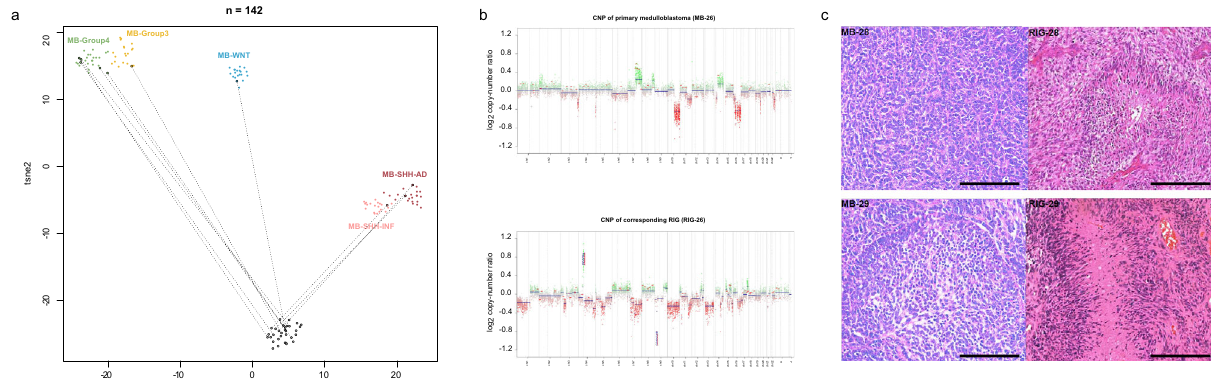
Fig. 4 Comparison of matched primary MB and post-radiation glioma samples. T-SNE analysis of primary MB and post-MB RIG compared with existing MB subgroups ( a ) and representative copy-number pro fi le ( b ) reveal distinct genome-wide methylation patterns and recurrent high-level PDGFRA ampli fi cation and CDKN2A/B deletion. Available primary MB and post-MB RIG samples ( n = 11 pairs) were investigated with 100 MB reference samples representing established MB subtypes 57,70 . MB and RIG pairs from our series were encircled and linked with dotted lines. Histological staining for hematoxylin and eosin ( c ) of two paired primary medulloblastoma and radiation-induced gliomas (MB/RIG_28, MB/RIG_29) display distinct morphological characteristics. Scale bar represents 200 μ m. T-SNE t-stochastic neighboring embedding, MB medulloblastoma, MB-SHH-INF medulloblastoma sonic- hedgehog infant subgroup, MB-SHH-AD medulloblastoma sonic-hedgehog adult subgroup, CNP copy-number pro fi Copy-number variation (CNV) analysis from 450k and EPIC methylation array instructions (Illumina, San Diego, USA). Data were generated at the Genomics and data was performed using the conumee Bioconductor package version 1.12.0. Proteomics Core Facility of the DKFZ (Heidelberg, Germany) and St. Jude Chil- All computational analyses were performed in R version 3.4.4 (R Development dren ’ s Research Hospital (Memphis, USA). DNA methylation data was generated Core Team, 2019). Raw signal intensities were obtained from IDAT- fi les using the from both fresh-frozen and formalin- fi xed paraf fi n-embedded (FFPE) tissue min fi Bioconductor package version 1.24.0. Illumina EPIC and 450k samples were samples. On-chip quality metrics of all samples were carefully controlled.